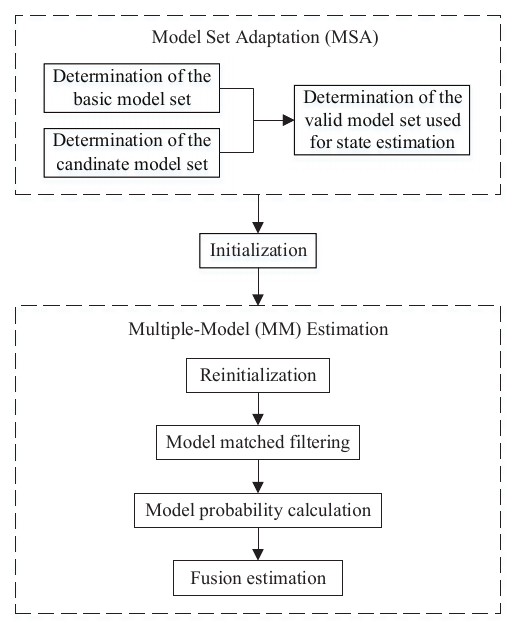
Figure 2. Framework of the VSMM algorithm based on